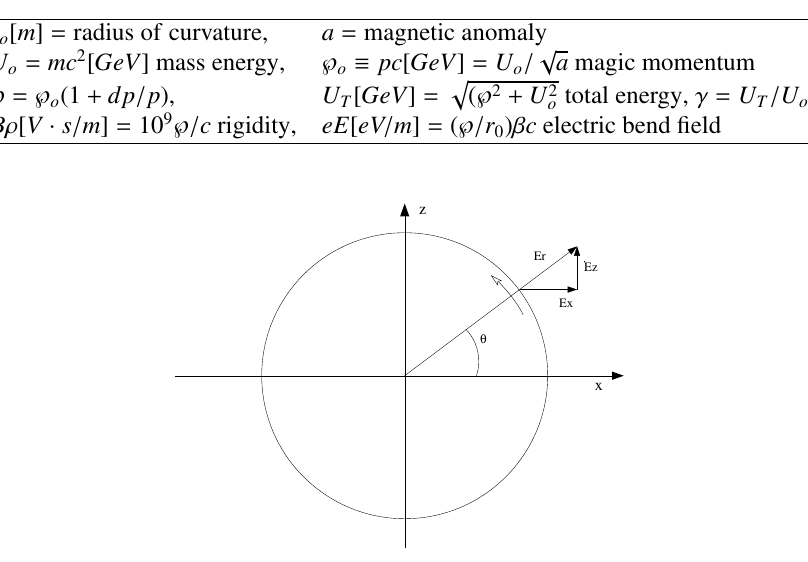
Figure 1. Reference Cartesian coordinates. ˆ y is out of the plane. The circular ring lattice shown is designed by tracking a "reference particle" i.e at the nominal, magic, energy injected tangentially.